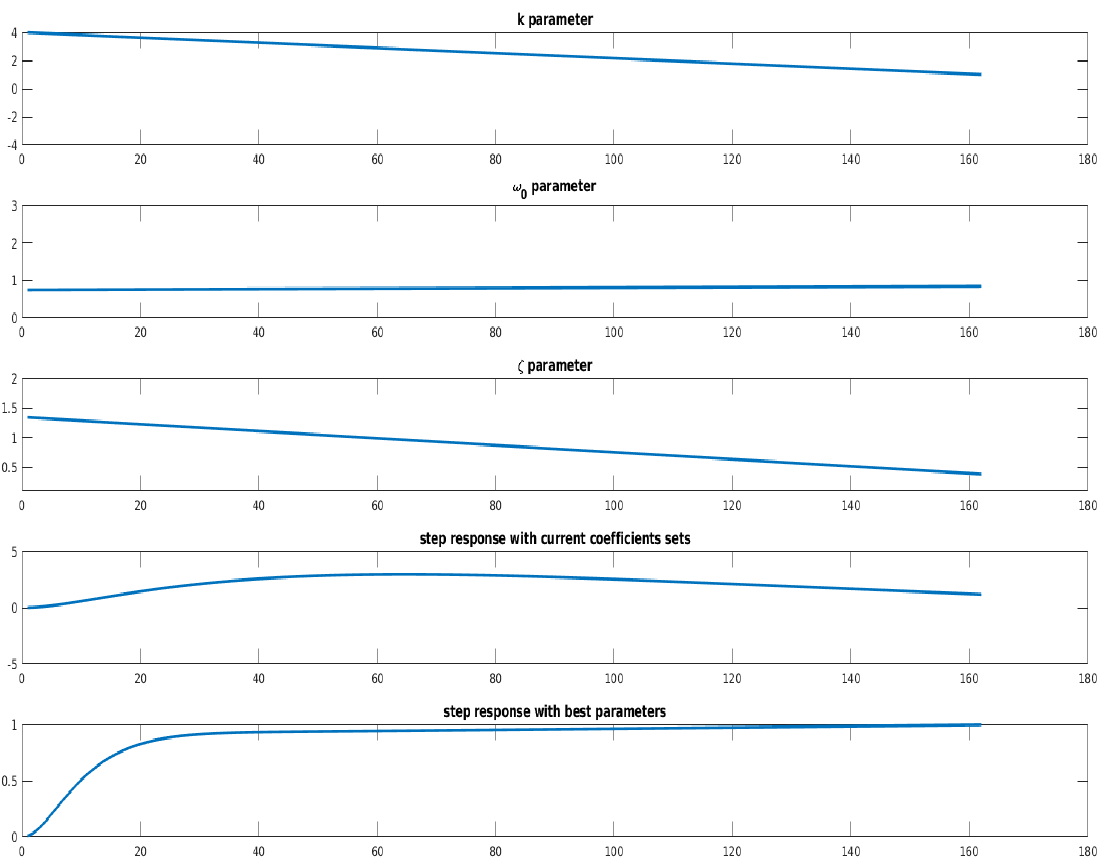
Figure 6. First stage of the optimization routine. The base filter is the digital oscillatory system with ζ =3.83 · 10 − 1 , ω 0 = 8.41 · 10 − 1 , k = 1, and t s = 1/10